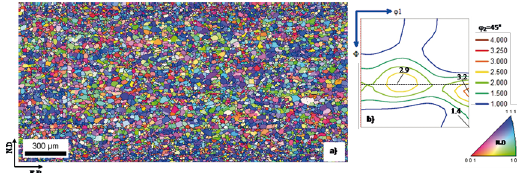
Figure 5. Micro-texture after 60% cold rolling and annealing: a) orientation map; b) ϕ =45° ODF section. 2